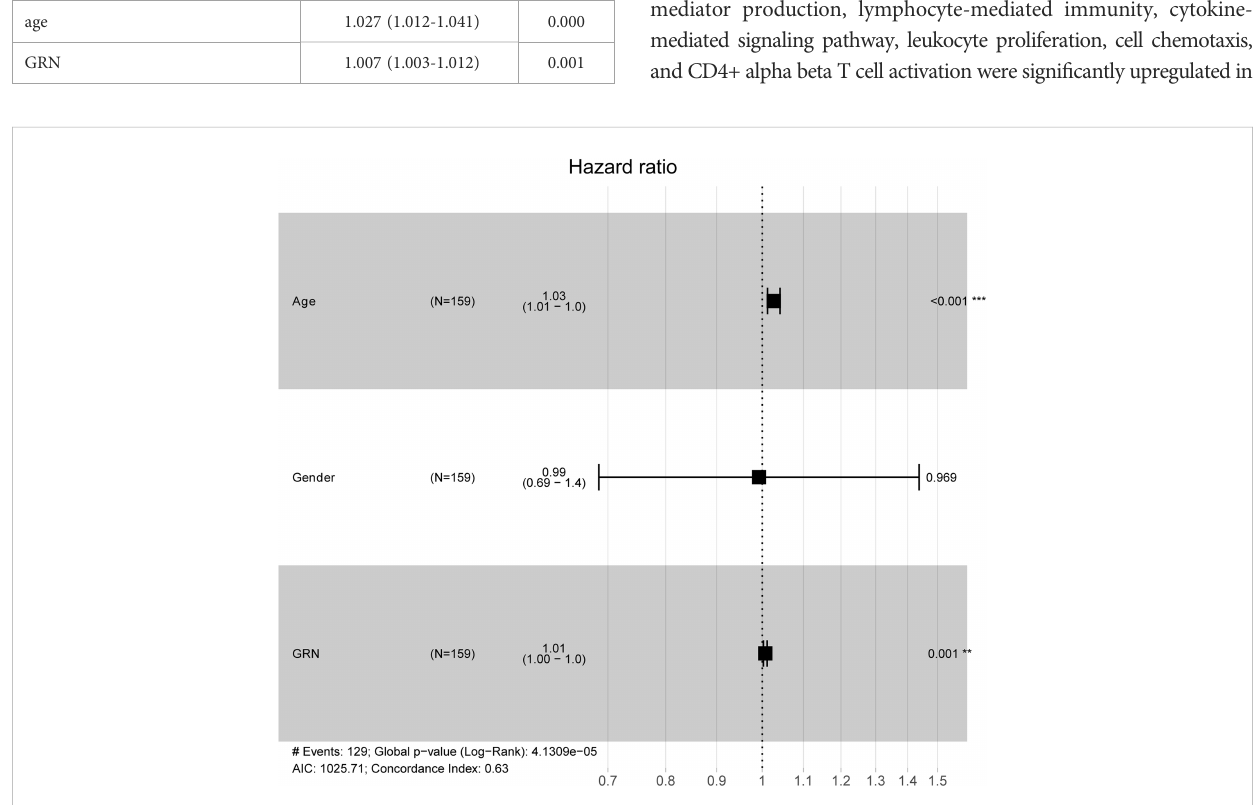
FIGURE 3 Multivariate Cox analysis of GRN expression and other clinical pathological factors. (As age and GRN expression are independent prognostic factors). **P < 0.01, ***P < 0.001.